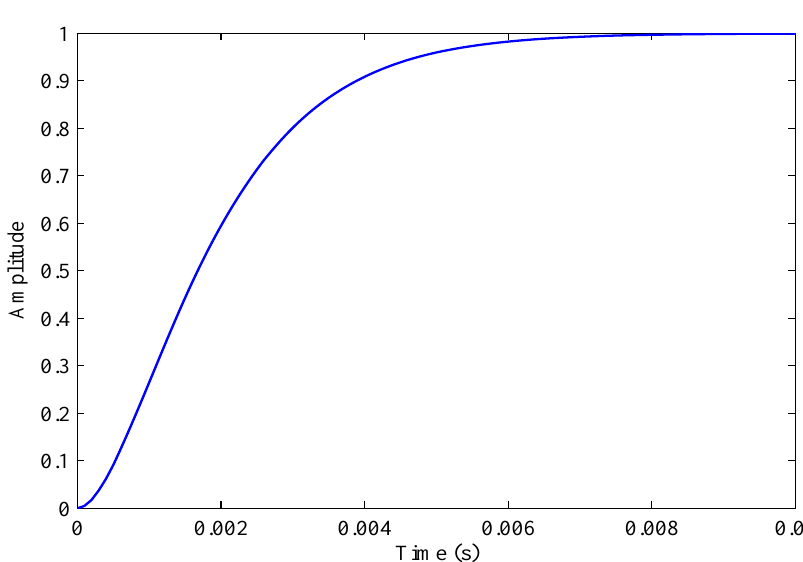
Figure 7. Step response obtained with the current control, R i ( s )